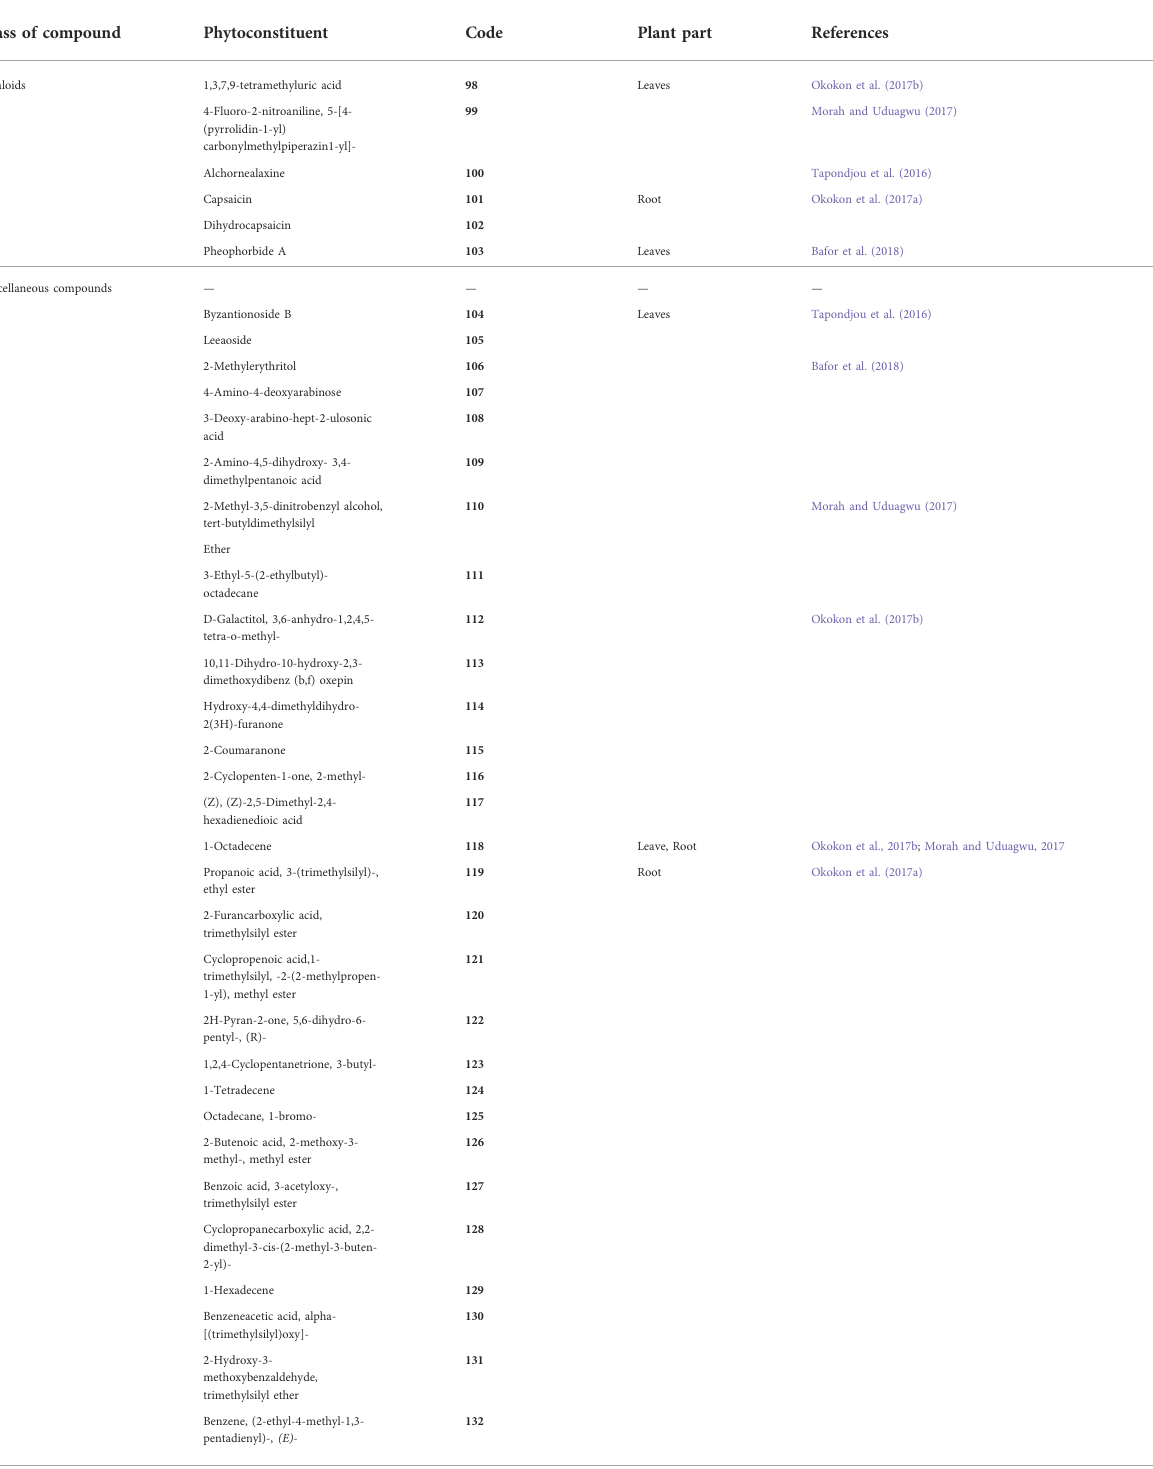
Bold values are the numbers mentioned for Chemical structures in the supplementary fi 7,4 ′ -disulphate and quercetin-3 ′ ,4 ′ -disulphate (Ogundipe et al., 2001a). In another study, taxifolin glycosides were isolated from